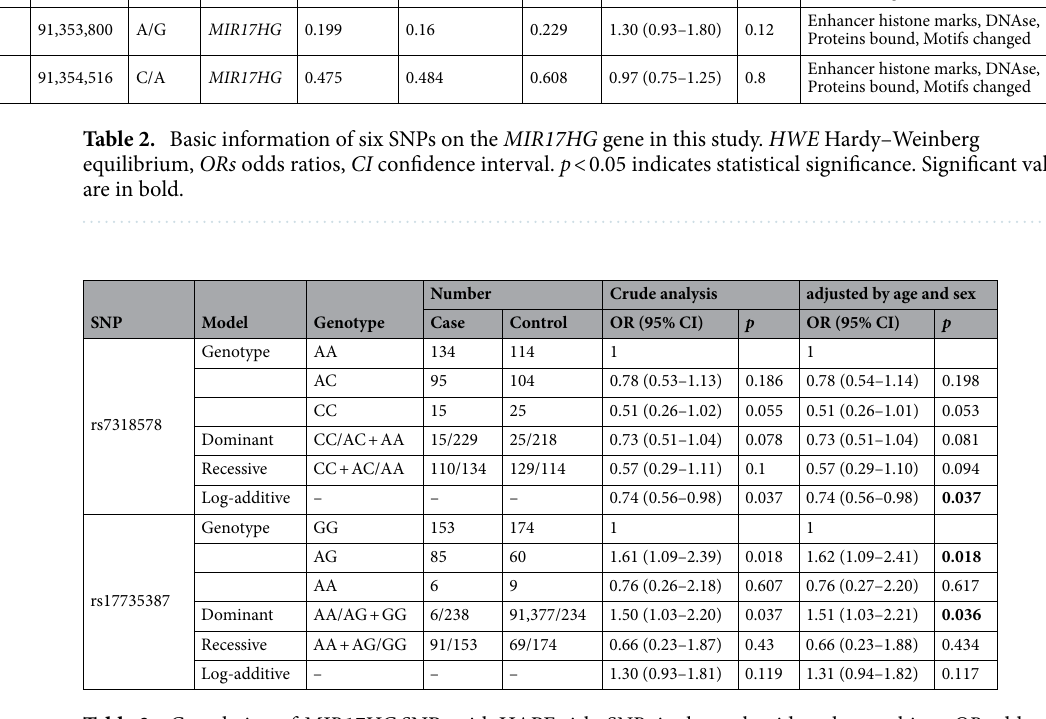
Table 3. Correlation of MIR17HG SNPs with HAPE risk. SNP single-nucleotide polymorphism, OR odds ratio, 95% CI 95% confidence interval. Significant values are in